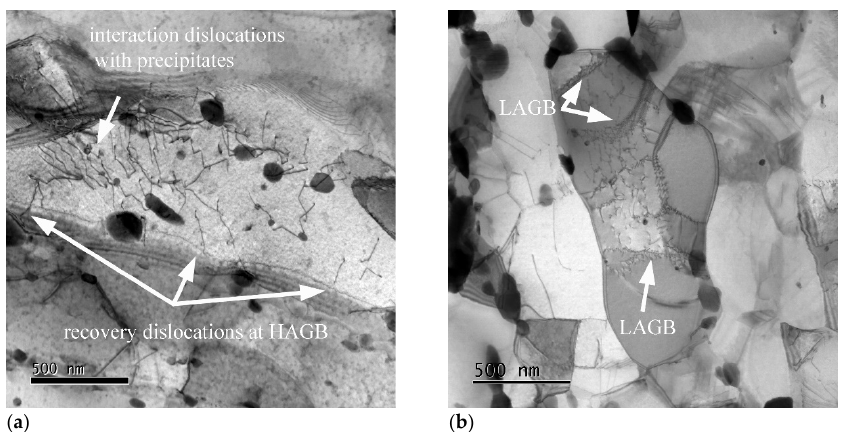
Figure 9. Dislocation microstructure in the gauge lengths of specimens tested: ( a ) 300 MPa and ( b ) 150 MPa.